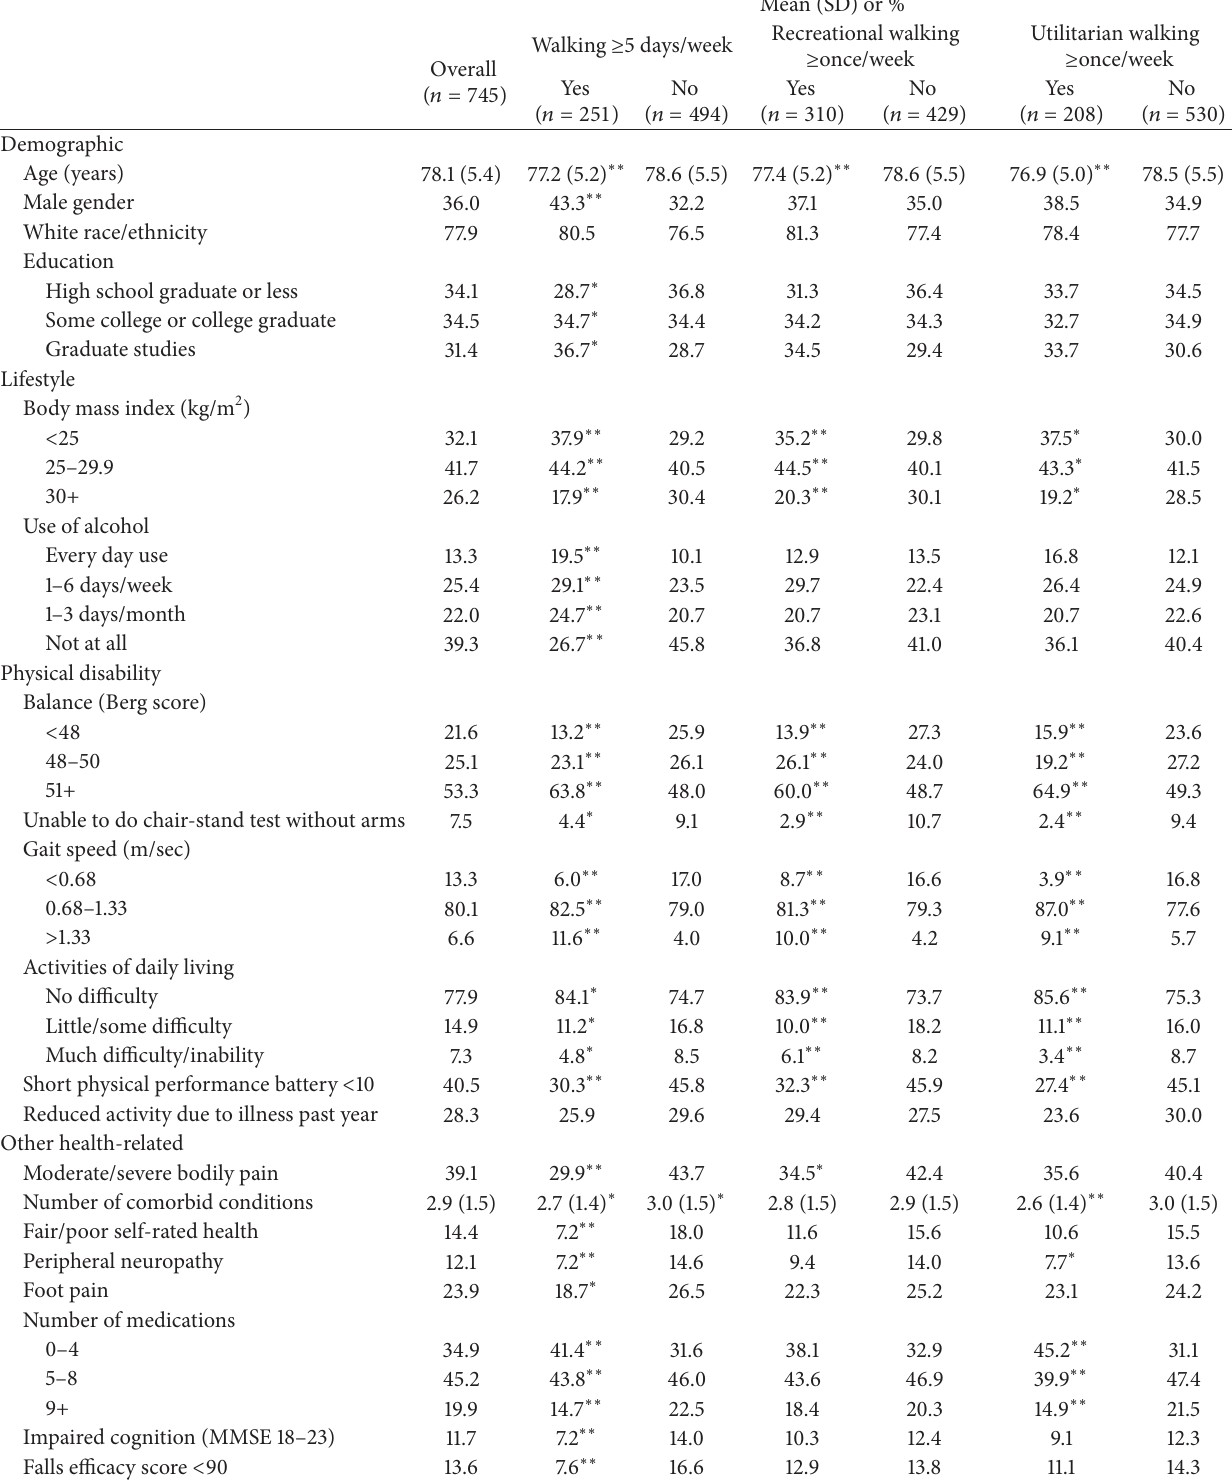
Table 1: Participants’ characteristics by walking